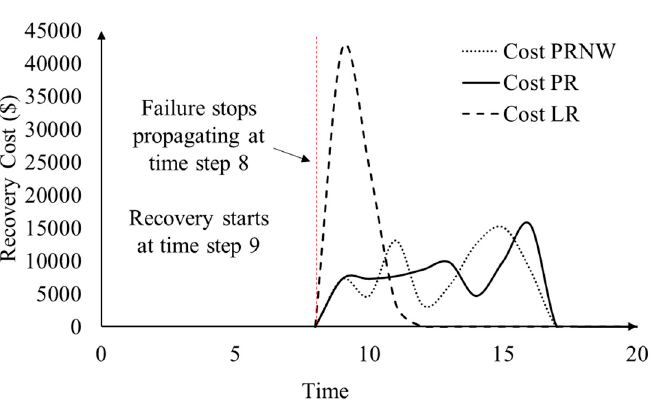
Figure 10. Changes in recovery cost in each time step.